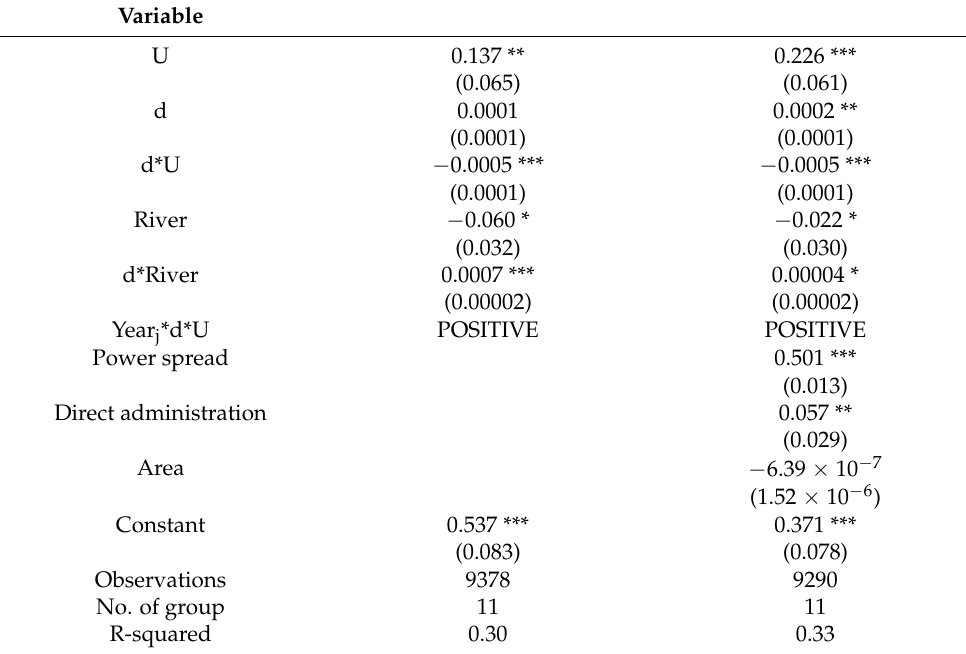
Table 8. Results estimating the extended model (dependent variable is ∆ logy it